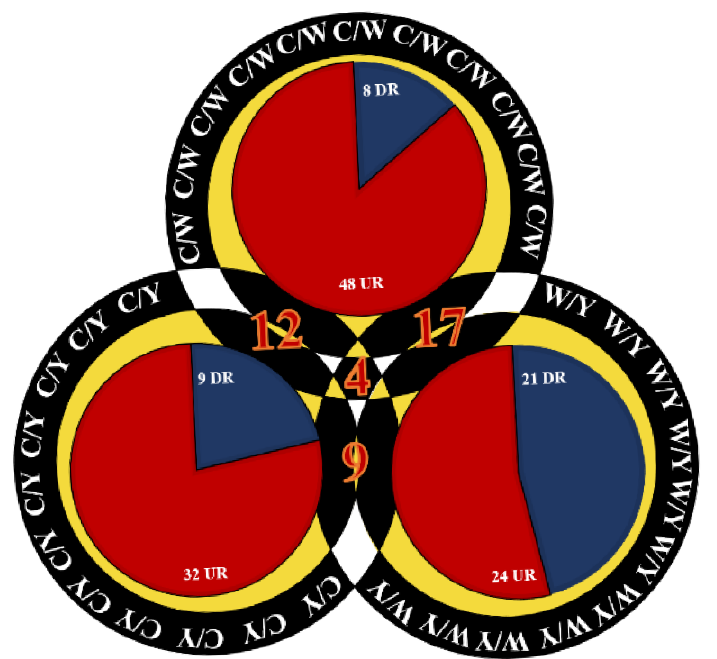
Figure 3. Venn diagram relationship of differentially expressed proteins on basis of regularity within the CW, CY and YW groups.